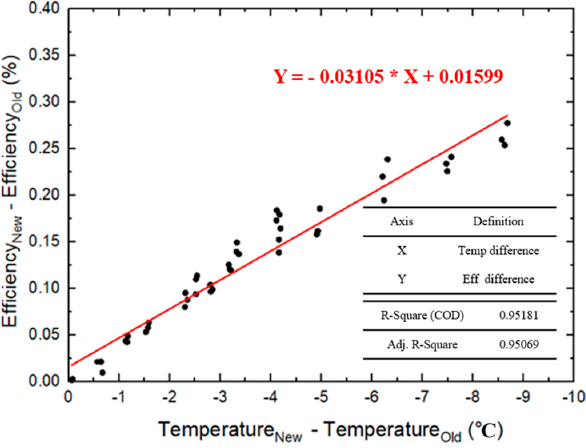
Figure 5. The temperature difference–efficiency difference correlation.